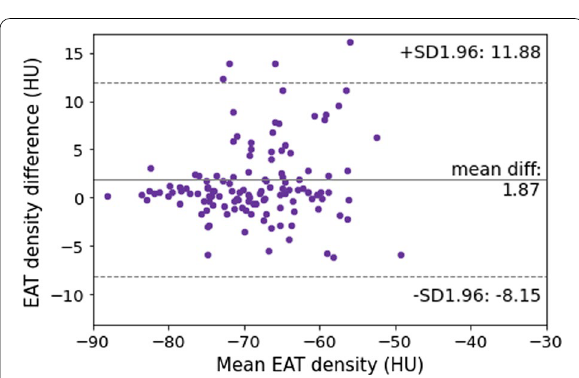
Fig. 4 Bland–Altman plot for inter-reader reproducibility of epicardial adipose tissue (EAT) density